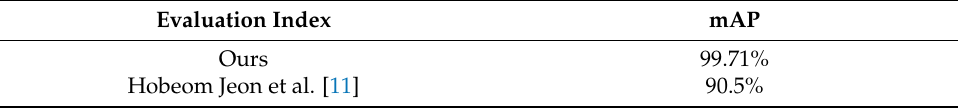
Table 14. Comparison of the mAP for fitness movement classification.